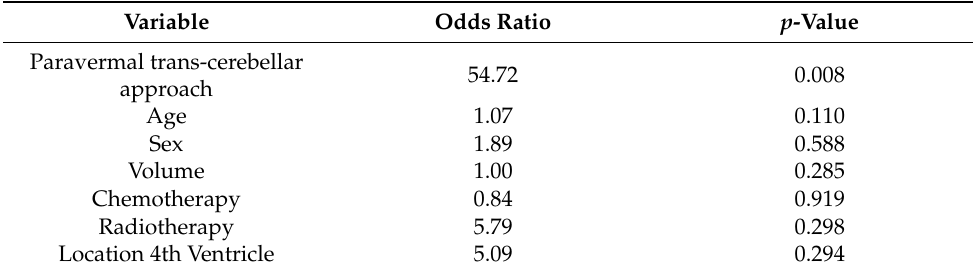
Table A2. Multivariate logistic regression predicting HOD development ( n = 45) based on 4th Ventricle localization. The multivariate logistic regression predicting HOD development is shown, due to partially missing information the analysis was run on n = 45.